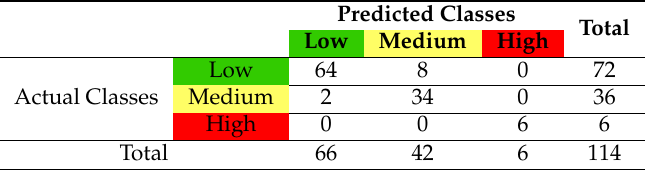
Table 10. An alternative 3-class contingency table for the railway stations of Abruzzo.